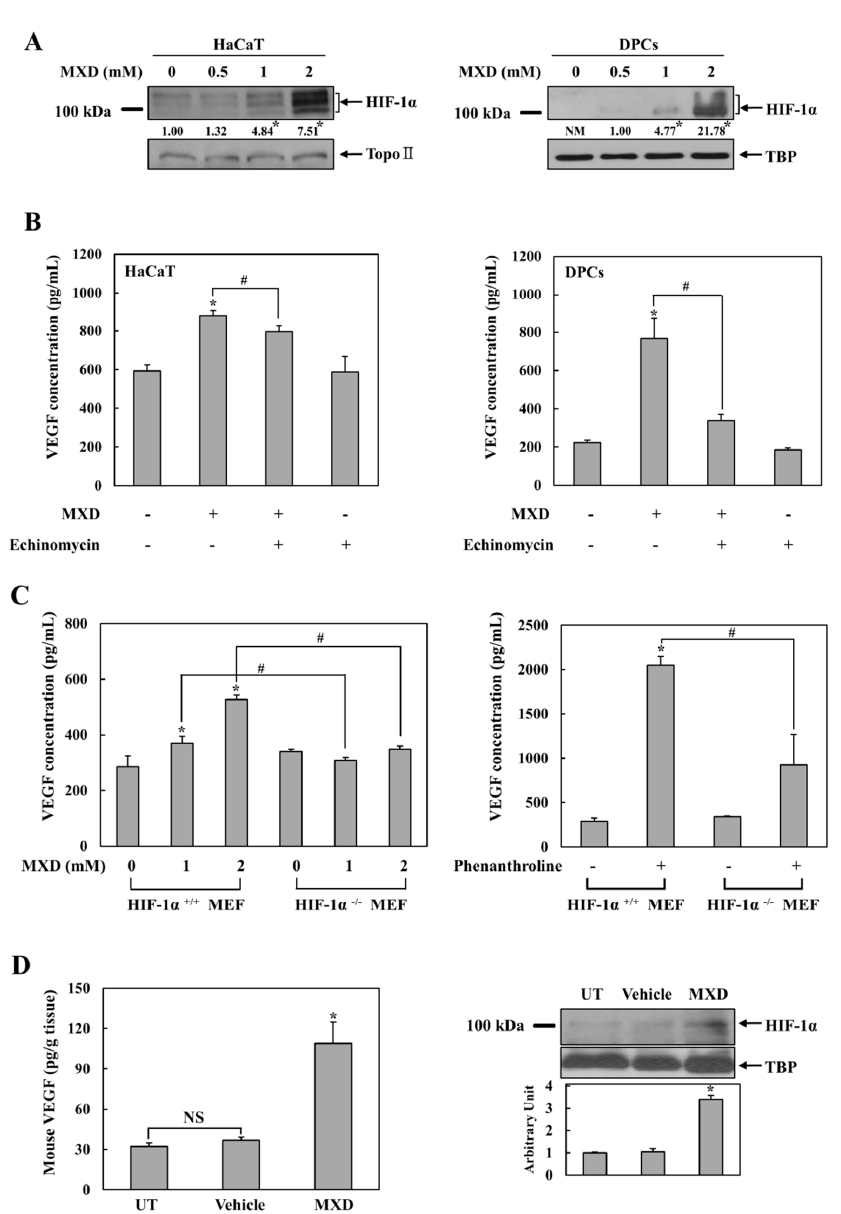
Figure 2. Millimolar minoxidil induction of VEGF is dependent on hypoxia-inducible factor 1 (HIF-1). ( A ) HaCaT cells (Left) or DPCs (Right) were treated with minoxidil (MXD) at various concentrations for 4 h, and HIF-1 α in the nuclear extracts was analyzed by Western blot ( n = 5). * p < 0.05 versus untreated group, NM: not measurable, TBP: TATA binding protein, Topo II: Topoisomerase II; ( B ) HaCaT cells ( Left ) or DPCs ( Right ) were treated with MXD (2 mM) for 10 h in the presence of echinomycin (20 nM) and VEGF secretion was monitored in cell culture supernatants by ELISA. * p < 0.05 versus untreated group, # p < 0.05; ( C ) Wild-type and HIF-1 α -deficient mouse embryonic fibroblasts (MEF) were treated with MXD ( Left ) or phenanthroline (200 μ M, Right ) for 10 h and VEGF secretion was monitored in cell culture supernatants. * p < 0.05 versus untreated group, # p < 0.05; ( D ) MXD (25 μ L of 5% Minoxyl solution/cm 2 ) or vehicle was applied to the dorsal area of Institute for Cancer Research (ICR) mice for 4 h. Secreted VEGF ( Left ) and nuclear HIF-1 α ( Right ) were analyzed in tissue lysates. Western blot results are representative of five independent experiments. * p < 0.05 versus untreated or vehicle group, NS: not significant, TBP: TATA binding protein, UT: untreated. The data represent the mean ± SEM ( n = 5).